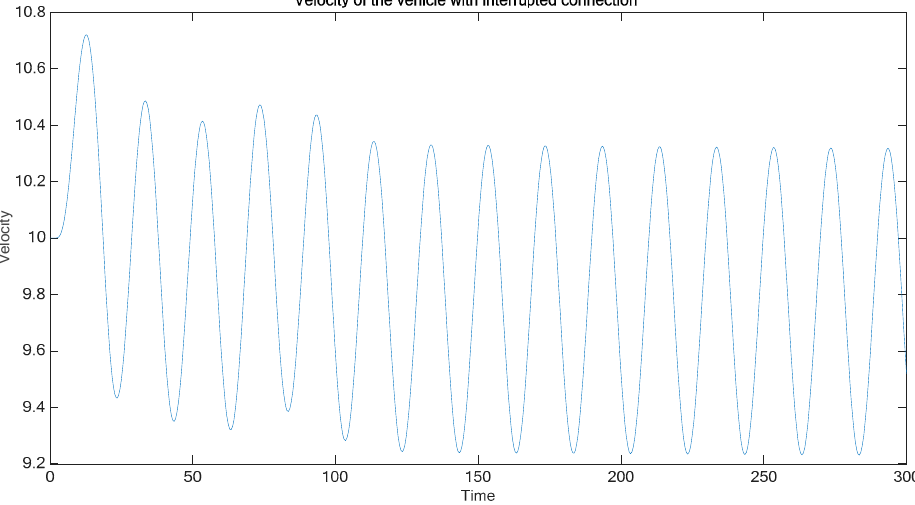
Figure 23. Small world model studied in Figure 11, the vehicle 21 breaks the long-range interaction after 100s.